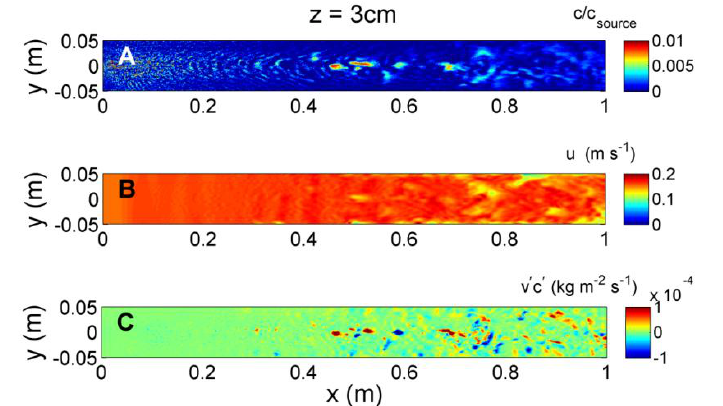
Figure 9. Instantaneous ( A ) odorant concentration; ( B ) horizontal velocity; and ( C ) transverse concentration flux ( v’c’ ) at z = 3 cm above the flume bed, obtained at t = 10 s after initial release of